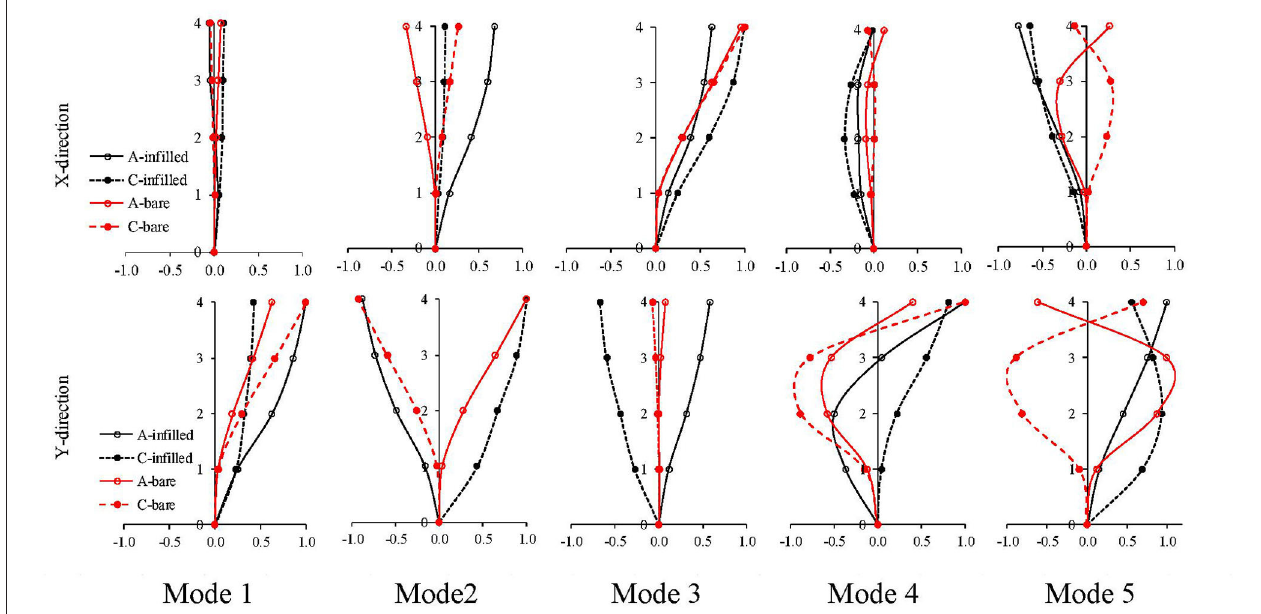
FIGURE 5 | Mode shapes obtained from the infilled (black line) and bare (red line) frame